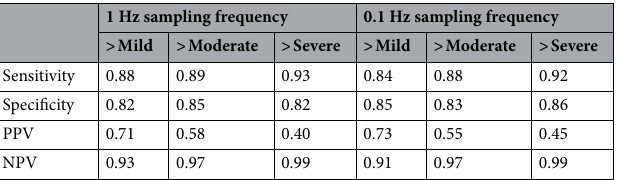
Table 2. Sensitivity, specificity, positive (PPV), and negative predictive values (NPV) for the best performing